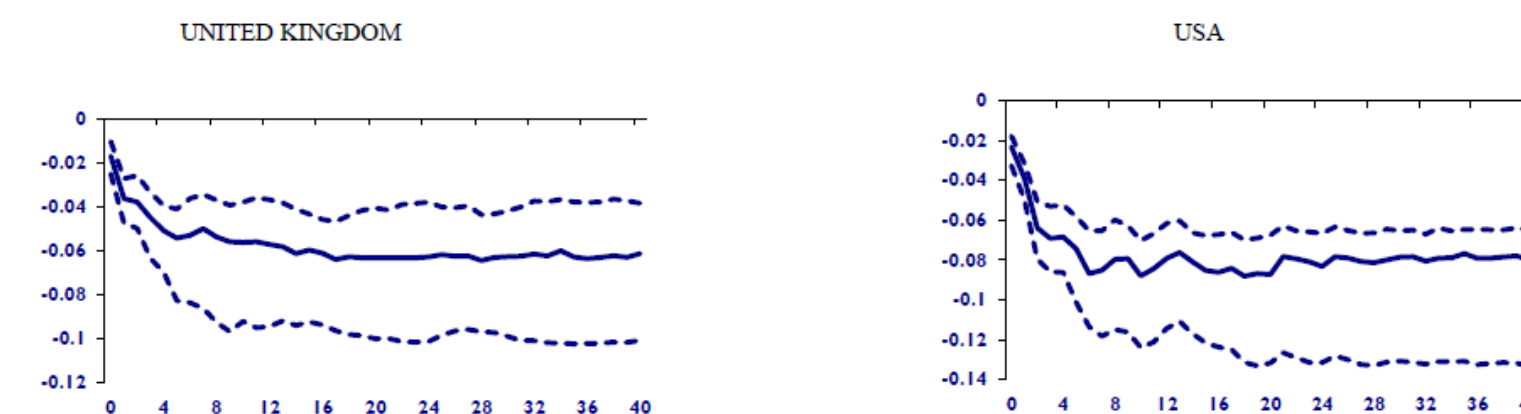
Figure 5. Country-specific oil price uncertainty shocks and real stock prices ( post-gfc ). Note: The figure depicts the country-specific impulse response functions of real stock prices to a one standard deviation increase in oil price uncertainty. The median impulse response is presented in solid lines, while the 16–84% lower and upper bootstrapped error bands are shown in dotted lines. The impact is measured in percentage points (by multiplying the estimates in the figure with 100) over the quarterly horizon.